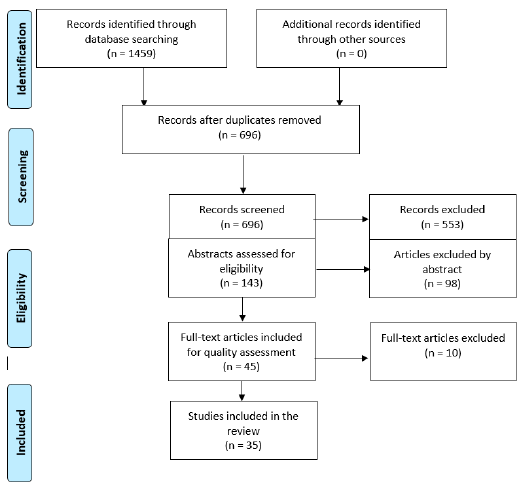
Figure 1. Flow diagram of the article selection process using the PRISMA flow diagram [12].